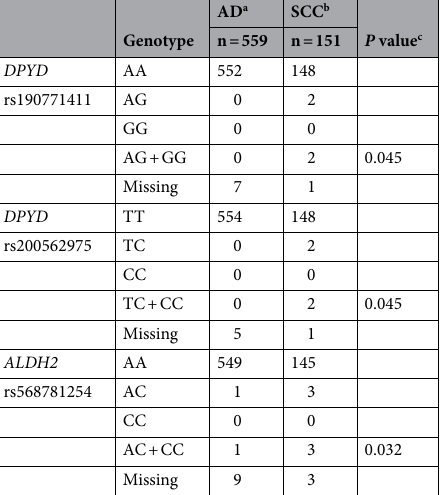
Table 3. The genetic variants of DPYD and ALDH2 show significantly different frequencies between adenocarcinoma and squamous cell carcinoma in patients with lung cancer. a AD adenocarcinoma, b SCC squamous cell carcinoma, c P value by Fisher’s exact test.